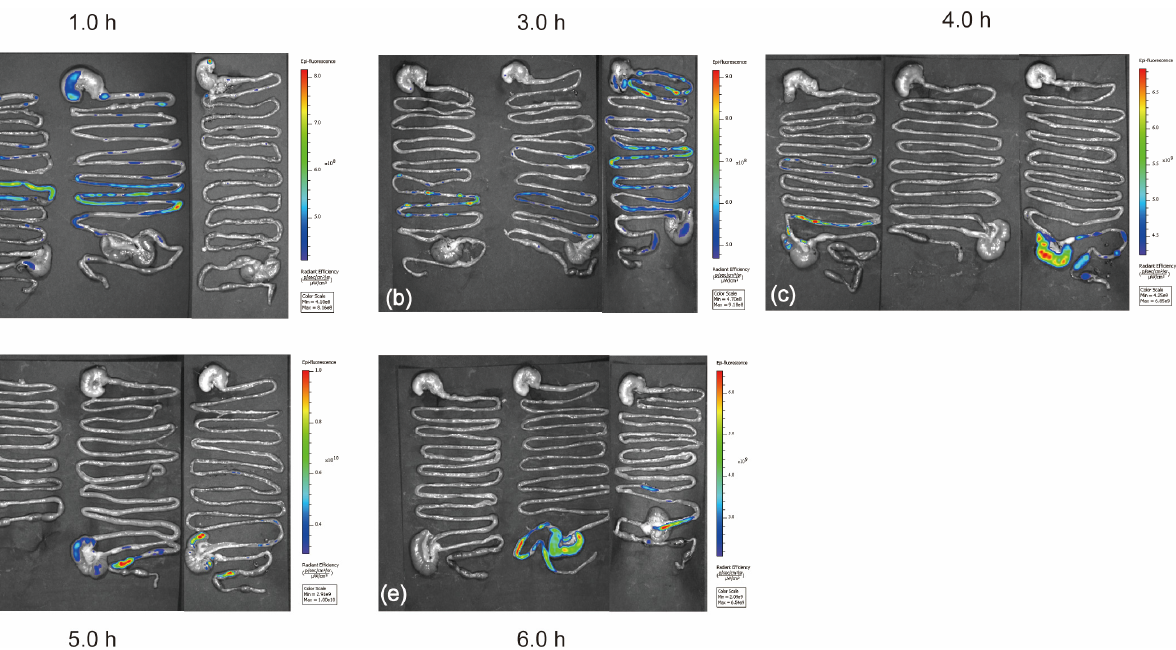
Figure 1. Intestinal fluorescence of rats indicating capsule transport.( a – e ) The gastrointestinal fluorescent images of rats at different time points. The red color indicates a higher fluorescence signal, and the blue color indicates a lower fluorescence signal.